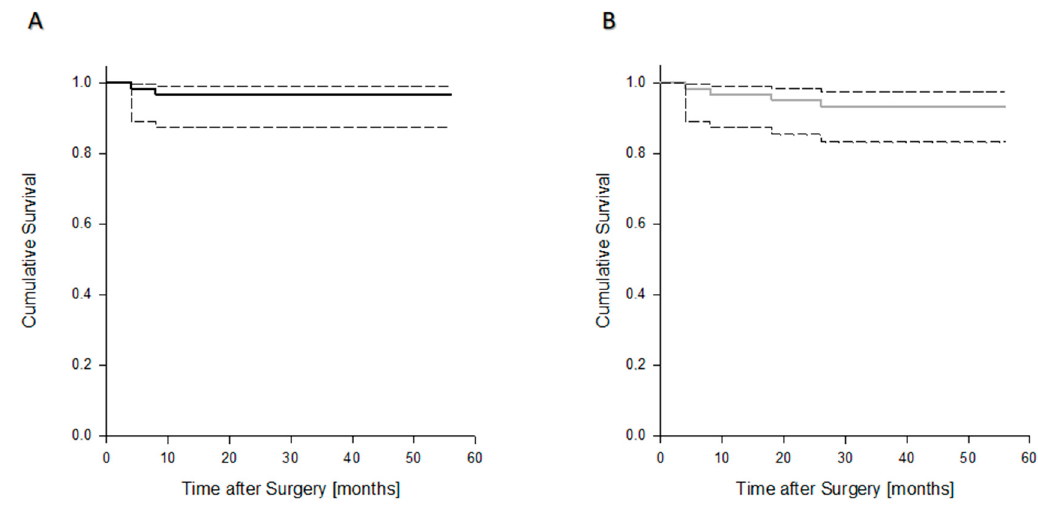
Figure 6. Kaplan–Meier curves demonstrating estimated overall implant survival ( A ) and revision-free survival ( B ).